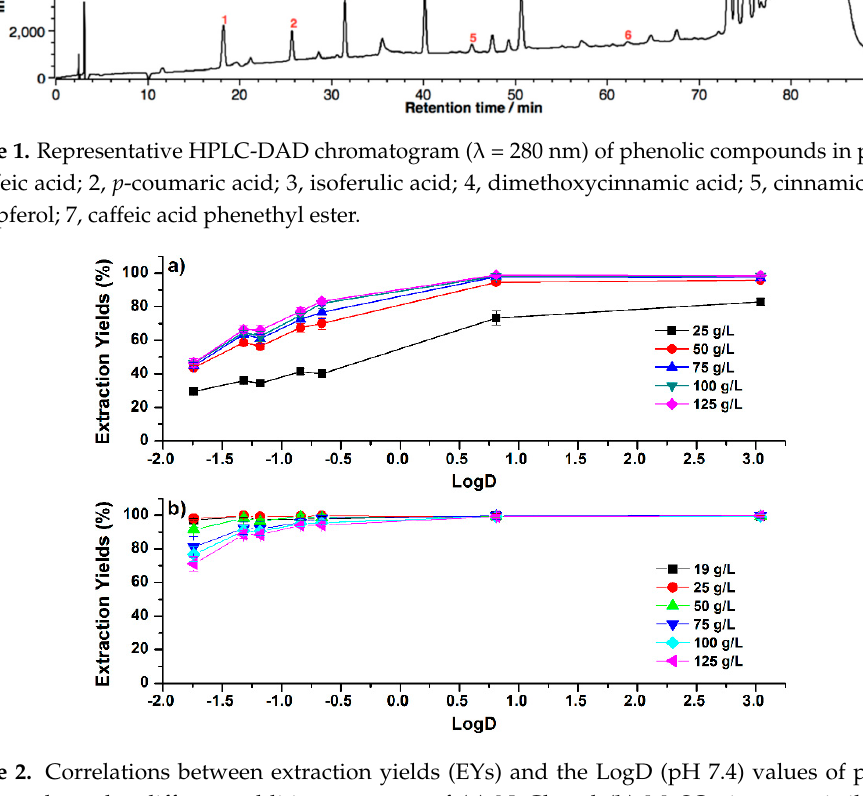
Figure 2. Correlations between extraction yields (EYs) and the LogD (pH 7.4) values of phenolic compounds under different addition amounts of ( a ) NaCl and ( b ) MgSO 4 in acetonitrile–water (ACN–H 2 O) mixture (50:50, v / v ). Error bars present the standard deviation ( n = 3). Compared with NaCl, lower salt concentrations of MgSO 4 are required to trigger the phase separation. In addition, higher EYs are achieved for all the estimated phenolic compounds in MgSO 4 - based SALLE. As shown in Figure 2b, EYs of the phenolic compounds were all larger than 97% when the concentration of MgSO 4 was 19 g/L in ACN–H 2 O mixture (50:50, v / v ). This higher partition efficiency of MgSO 4 compared with NaCl was similar with reports on the SALLE of dicarbonyl [28] and fatty acid [29] compounds, which can be attributed to the larger phase ratio in MgSO 4 -based SALLE than that in NaCl-based SALLE. As shown in Figure 2, EYs of more-polar phenolic compounds with LogD < 0 (caffeic acid, p -coumaric acid, isoferulic acid, dimethoxycinnamic acid, and cinnamic acid) in NaCl-based SALLE are lower than those in MgSO 4 . However, EYs of the less- polar phenolic compounds with logD > 0 (kaempferol and CAPE) in NaCl-based SALLE are similar with those in MgSO 4 -based SALLE. This means that though the phase ratio is lower in NaCl-based SALLE [28], EYs of less-polar compounds are comparable to the high phase ratio conditions of MgSO 4 -based SALLE. Additionally, when the concentration of MgSO 4 was increased to 125 g/L, the volume of the upper phase was decreased. This decrease of phase ratio with the increase in MgSO 4 concentration is consistent with the results reported by Valente et al. [28]. Consequently, the decrease in the EY of the most polar compound (caffeic acid) was from 98.0% to 71.2%, while for the least polar compound (CAPE), EY varied between 99.3% and 99.8% (Figure S2b). These observations indicate that the influence of the phase ratio on partition efficiency is more significant when the polarity of the estimated compounds is higher. It also implies that EYs of polar compounds may be improved by increasing the phase ratio. Increasing the initial concentration of ACN in ACN–H 2 O mixtures can lead to the increase of phase ratio [29]. Consequently, the improvement of EYs for more-polar compounds were observed. For NaCl-based SALLE, as shown in Figure 3a, when the ACN concentration in the ACN–H 2 O mixture was increased to 70:30 (ACN:H 2 O, v / v ), the EYs of phenolic compounds were all higher than 81.8%. In addition, the influence of initial ACN concentration on EYs is more significant for more- polar phenolic compounds than for less-polar phenolic compounds. For instance, as the initial concentration of ACN increased from 40:60 to 70:30 (ACN:H 2 O, v / v ), EYs of caffeic acid were increased from 21.0% to 81.8%, while for CAPE, EYs were increased from 88.4% to 99.9%. In MgSO 4 - based SALLE, as shown in Figure 3b, the influence of the initial concentration of ACN on EYs is much